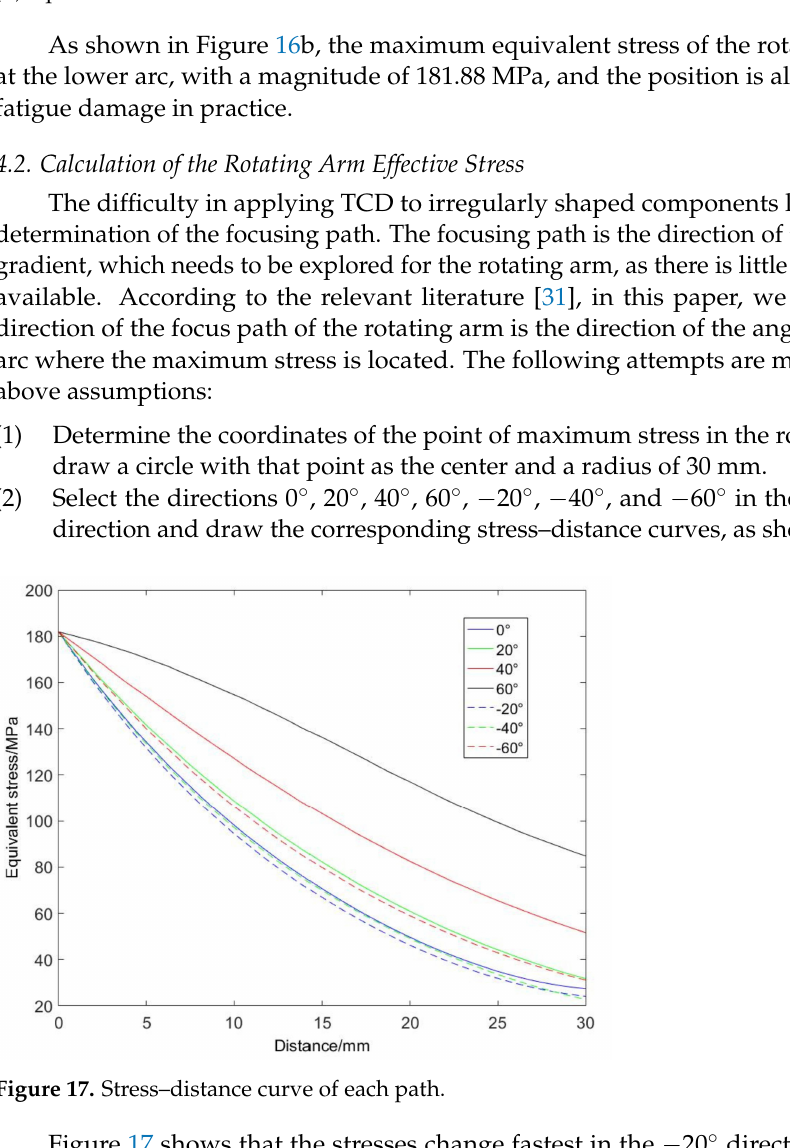
Figure 16. Static simulation analysis of the rotating arm: ( a ) applying loads and constraints; ( b ) equivalent stress cloud chart.